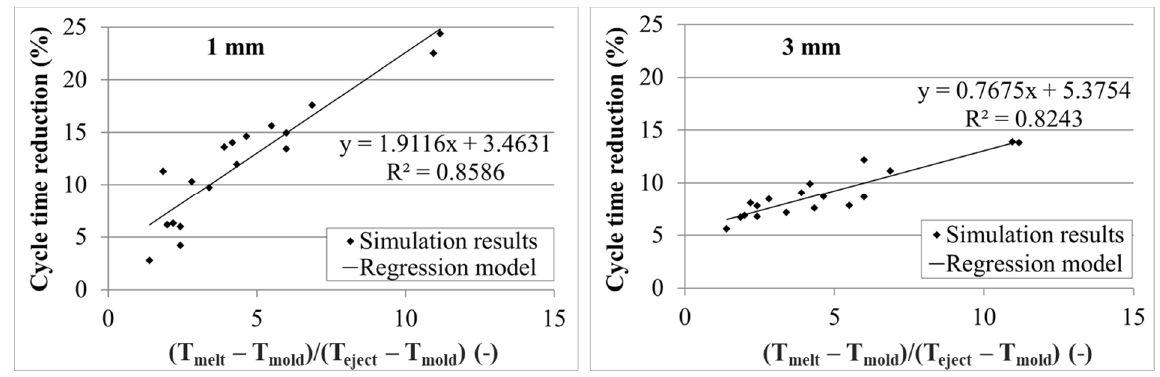
Figure 7. Correlation between temperature coefficient (TC) and cycle time reduction (CTR) for two wall thicknesses (left: 1 mm, right: 3 mm).